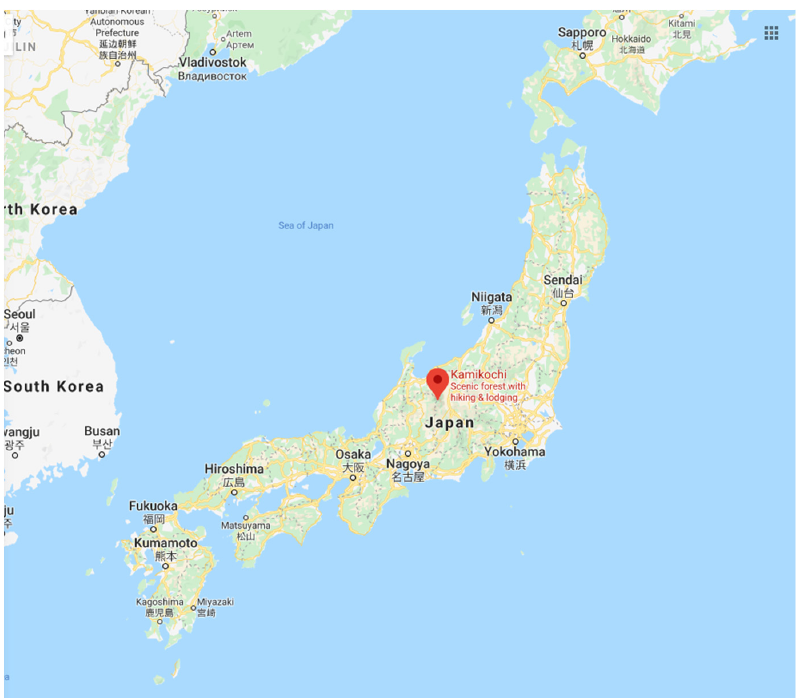
Figure 1. Location of Kamikochi in Japan (Google Maps).